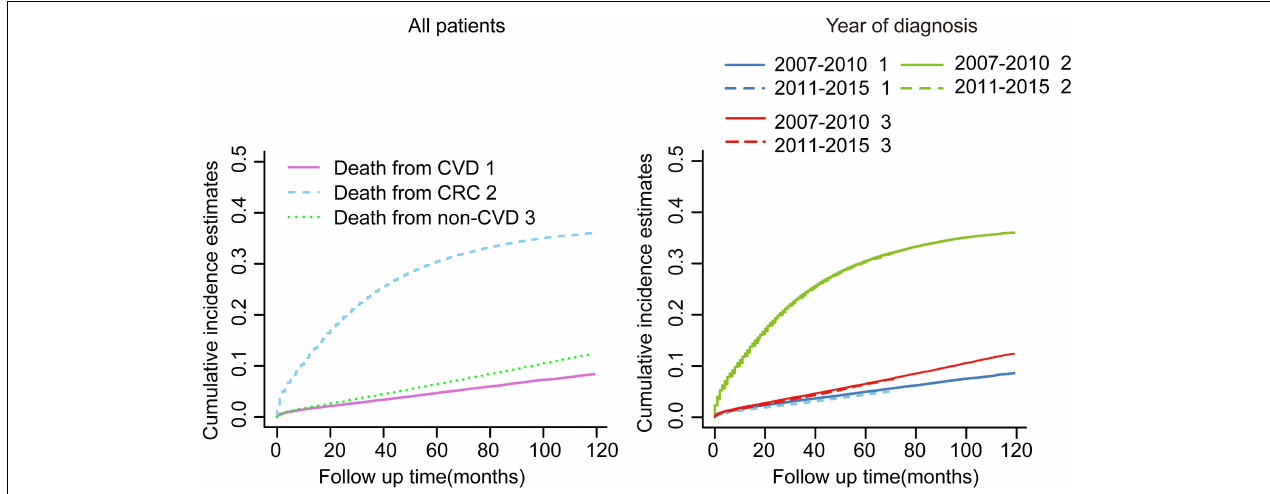
FIGURE 1 | Cumulative incidence estimates of cardiovascular death (CVD) among patients with colorectal cancer (CRC) in the whole cohort. Death from CVD was indicated as 1; death from CRC was indicated as 2; and death from non-CVD was indicated as 3.